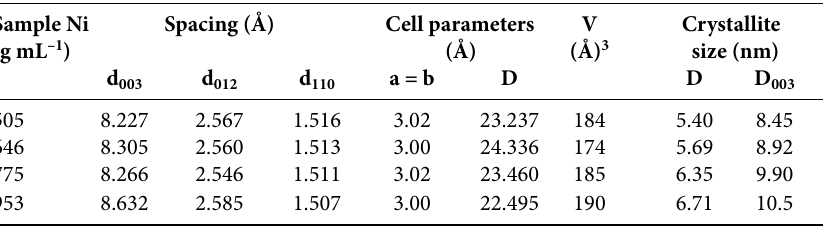
Table 7. Lattice parameters and size of Ni/Al-LDH crystallites Sample Ni Spacing (Å)